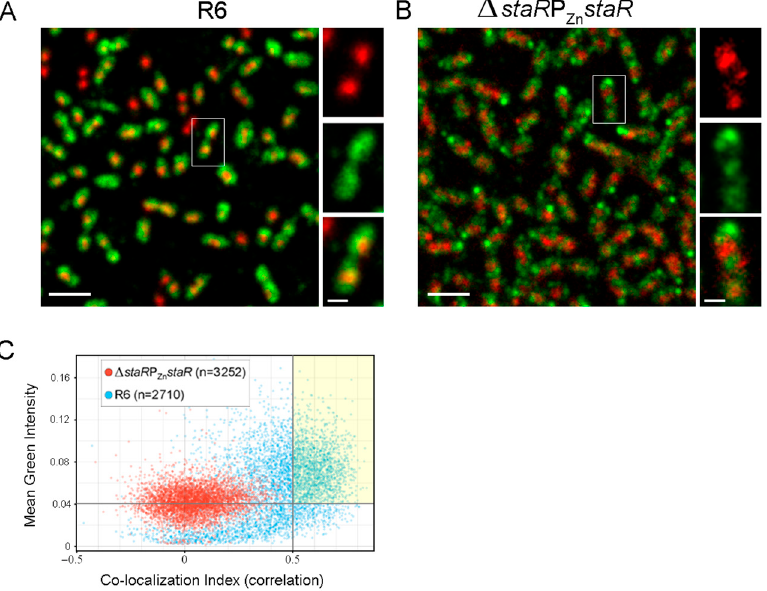
Figure 5. StaR localizes to the nucleoid. Strain R6 and ∆ staR P Zn staR were grown in the absence of ZnSO 4 to mid-log phase (OD 620 nm = 0.4). Cells were fixed, the nucleoids were stained with Sytox orange and StaR was immunostained using the Abberior Star 488 anti-rabbit secondary antibody as described in the Materials and Methods section. STED microscopy was used to determine the intracellular localization of nucleoids and StaR. ( A ) General view (left panel) and inset of a representative co-localizing cell of R6, showing nucleoids (red) and StaR labeling (green). Scale bar indicates 2 μ m in the general views or 0.5 μ M in the insets. ( B ) General view (left panel) and inset of a representative co-localizing cell of Δ staR P Zn staR , as a control of StaR depletion. ( C ) Pearson correlation analysis of the strains indicated in (A,B). y -axis represents the mean intensity of green label (StaR) for Δ staR PZn staR (red points) and R6 (blue points) and the x -axis indicated the Pearson correlation between green and red (nucleoids) labels. Gray lines in the x- and y -axis correspond to the thresholds applied to calculate the number of cells where StaR co-localizes with the nucleoid. A yellow square highlights the R6 population showing StaR–nucleoid co-localization.